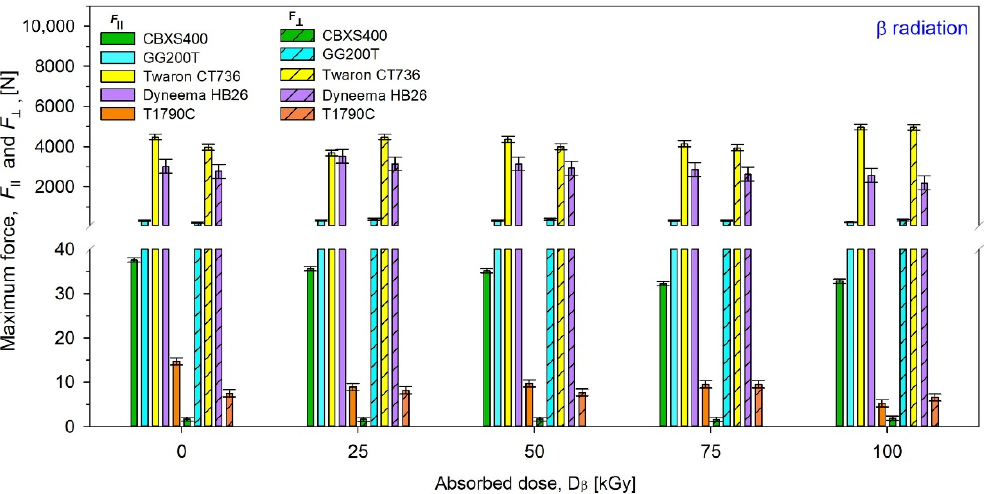
Figure 15. Maximum force of unmodified and β irradiated textiles.